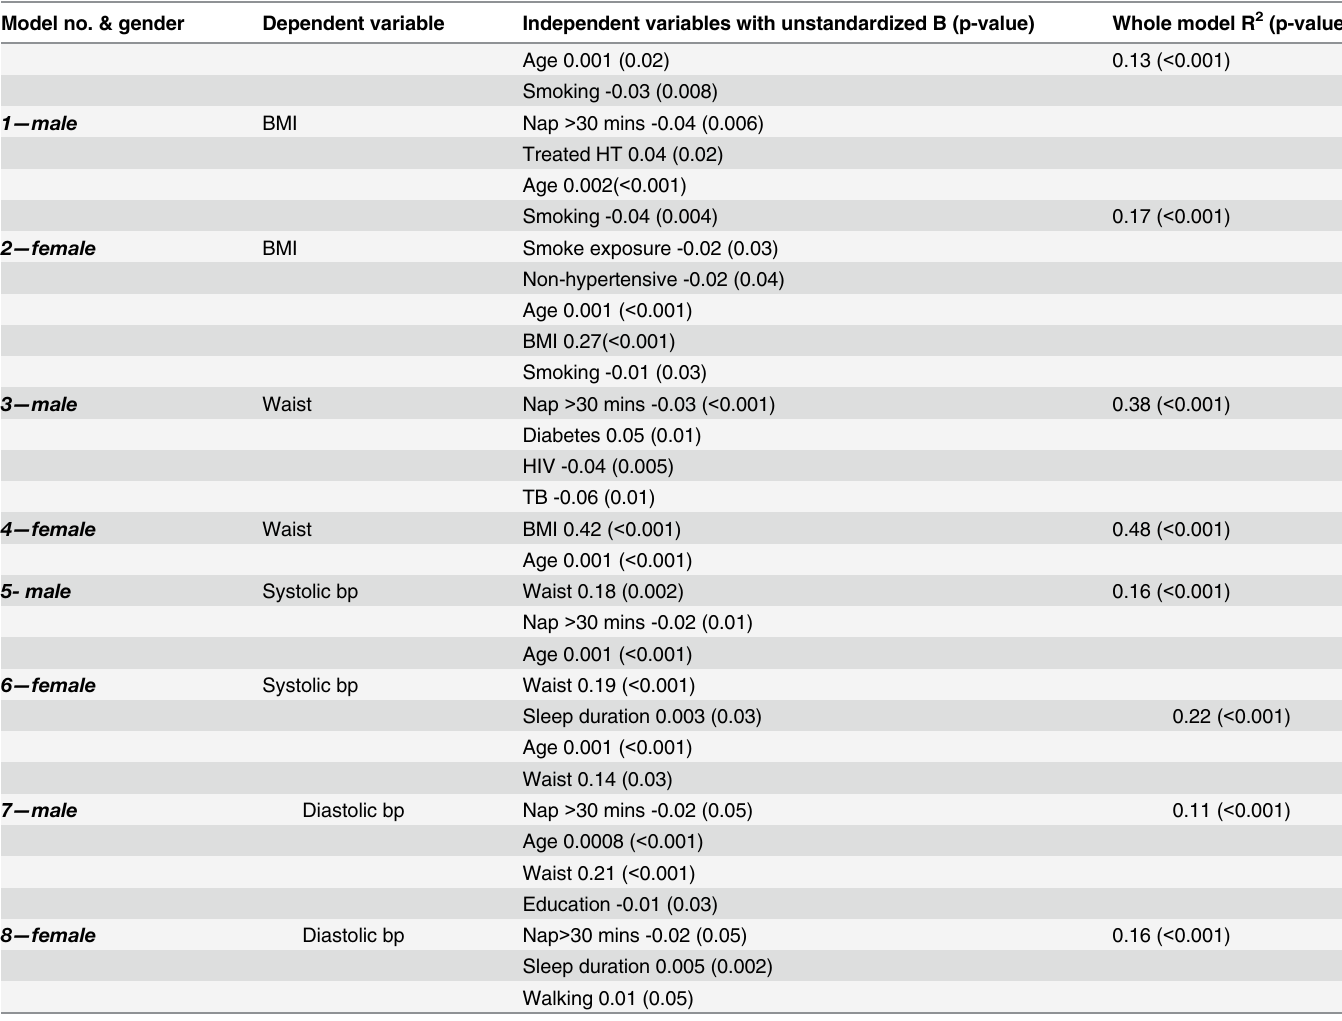
Table 3. Multiple regression models for BMI, waist circumference and blood pressure in male and female subjects. Model no. &